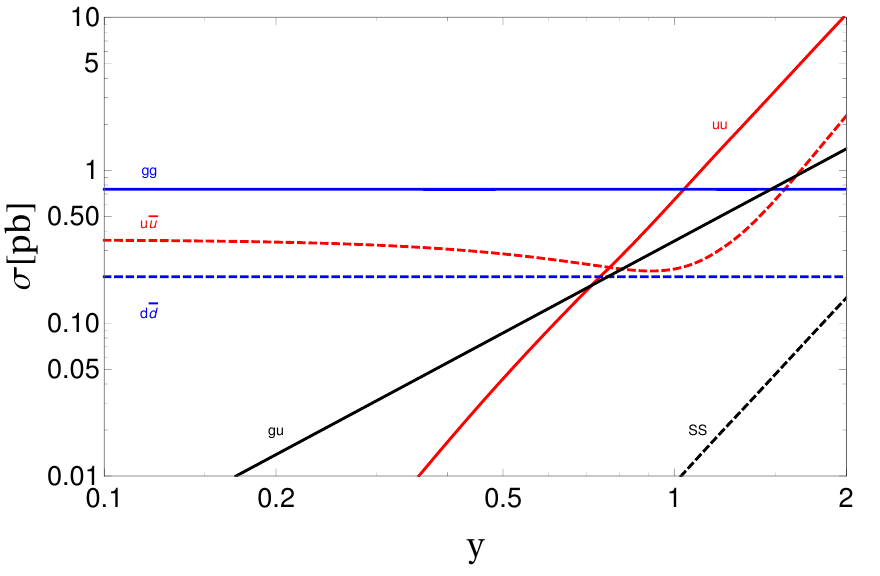
p Figure 6 . New physics production cross sections at the s = 13 TeV LHC as a function of the Yukawa coupling y for a representative choice of the masses ( M S = 500 GeV and M F = 550 GeV). The pure gauge mediated production of mediator pairs from gg ( d (cid:22) d ) initial states is shown by the blue solid (dashed) line. The mixed gauge and new physics mediated production from u (cid:22) u is indicated by the dashed red line while the exclusively new physics induced cross section for particle- particle production from uu initial states is marked by the solid red line. The cross section of mixed DM mediator (cid:12)nal states from gu is shown as black, solid. For comparison we also show the direct SS production cross section as black,